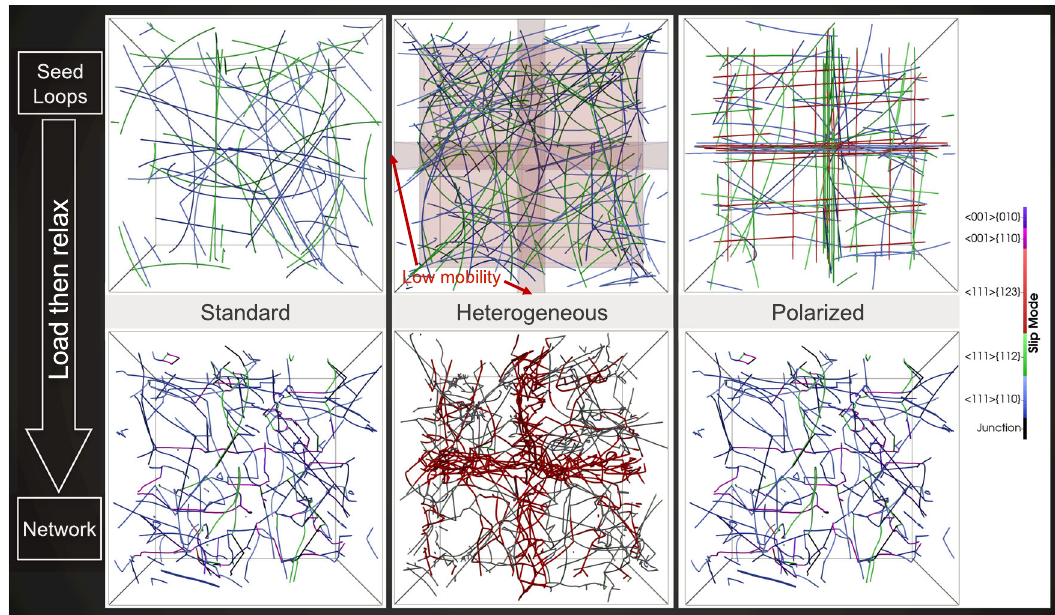
Fig. 1 A schematic illustrating the three types of dislocation networks used in this study. Standard networks are roughly homogeneous and have no geometrically necessary content (on the scale of the full box). Heterogeneous networks have dislocations concentrated near the box midplanes. Polarized networks are seeded with geometrically necessary dislocations. Standard networks were generated in a variety of box sizes, targeting multiple